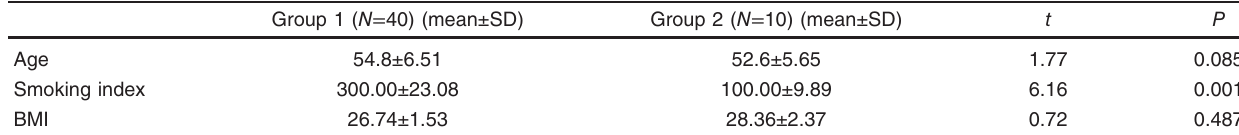
Table 1 Demographic data of the patients with chronic obstructive pulmonary disease and